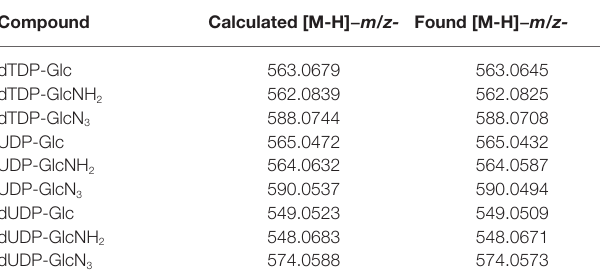
TABLE 2 | MS analysis of the products catalyzed by